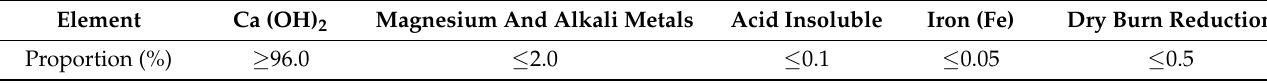
Table 7. Chemical composition of slaked lime.